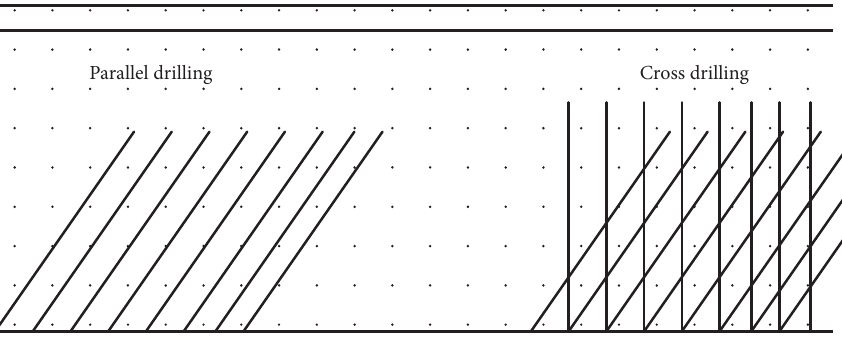
Figure 10: Drill hole layout.